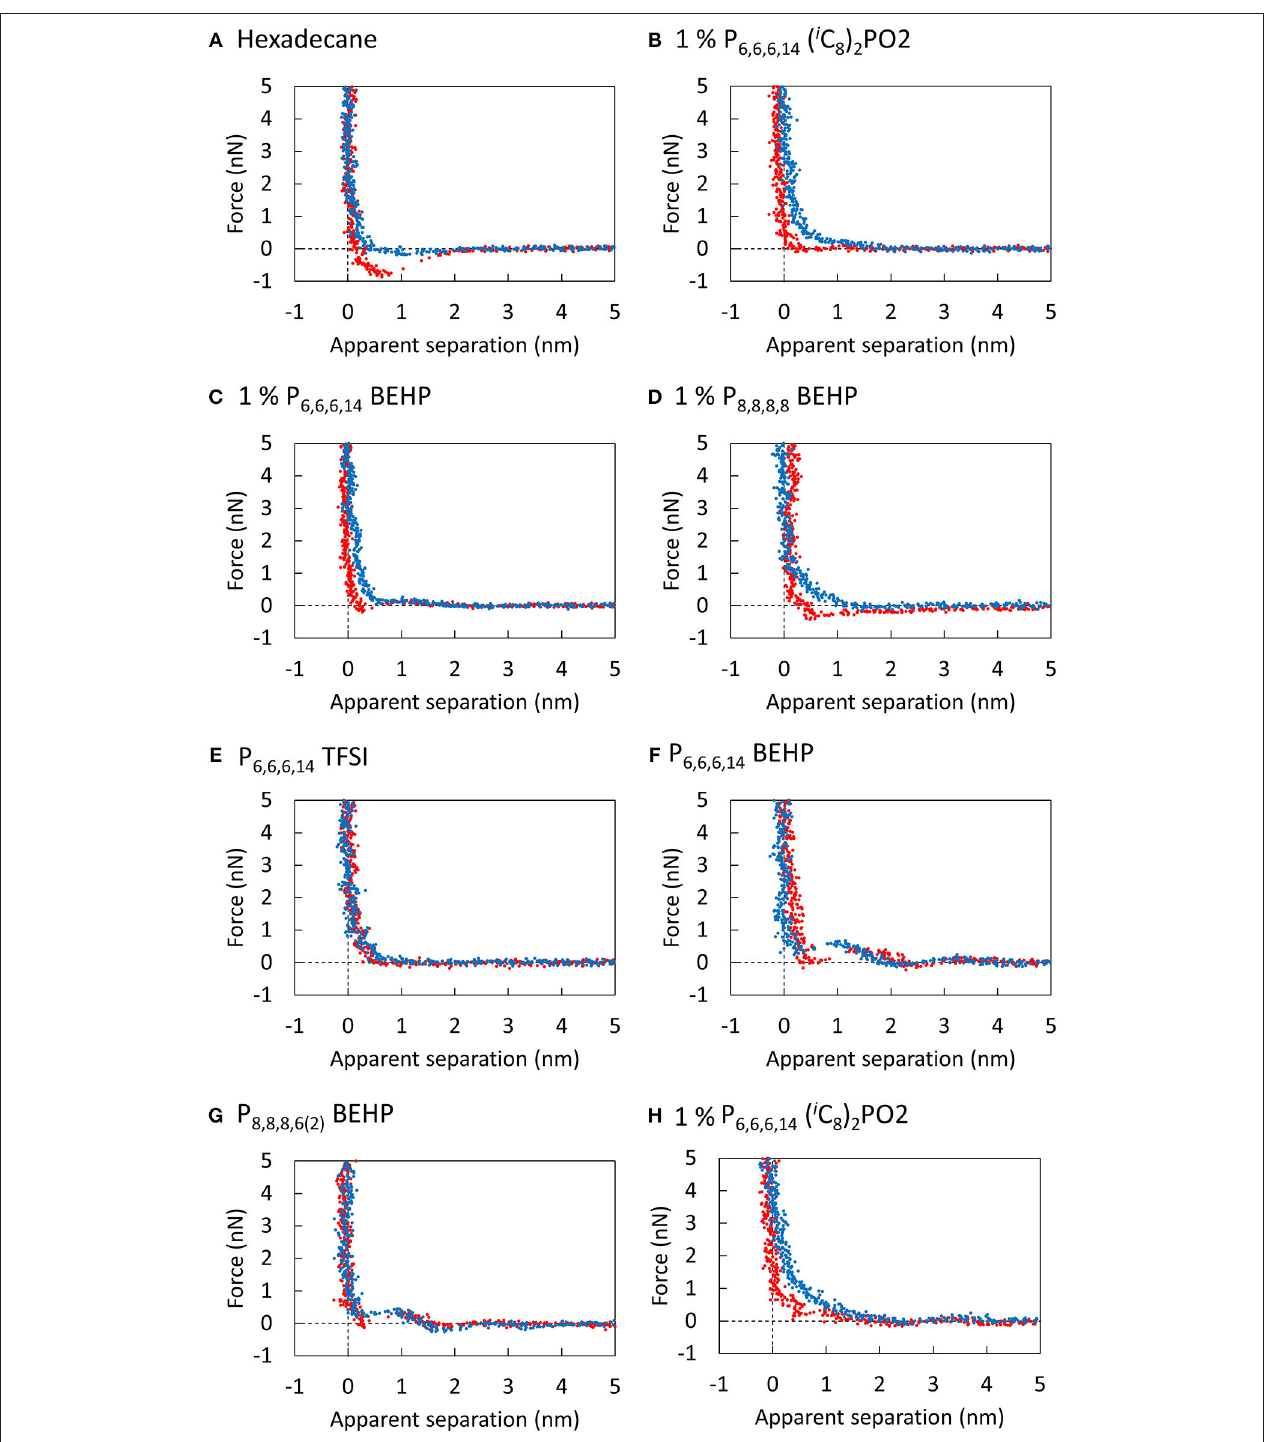
FIGURE 4 | Force curves of the silicon AFM tip approaching (blue) and retracting (red) from the unpolished titanium surface submerged in (A) Hexadecane, (B) 1% P 6,6,6,14 ( i C 8 ) 2 PO 2 , (C) 1% P 6,6,6,14 BEHP, (D) 1% P 8,8,8,6(2) BEHP, (E) P 6,6,6,14 TFSI, (F) P 6,6,6,14 BEHP, (G) P 8,8,8,6(2) BEHP, and (H) 1% P 6,6,6,14 ( i C 8 ) 2 PO 2 . Scan size: 30nm.